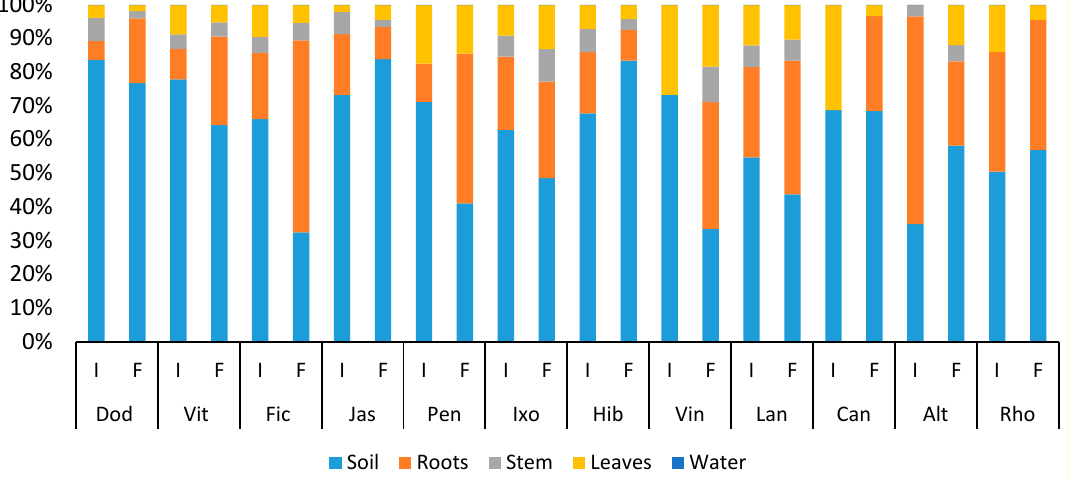
Figure 8. Distribution of Cr in the biofiltration components at the beginning (I, before irrigation with greywater) and at the end (F, after irrigation with greywater) of the experiment.